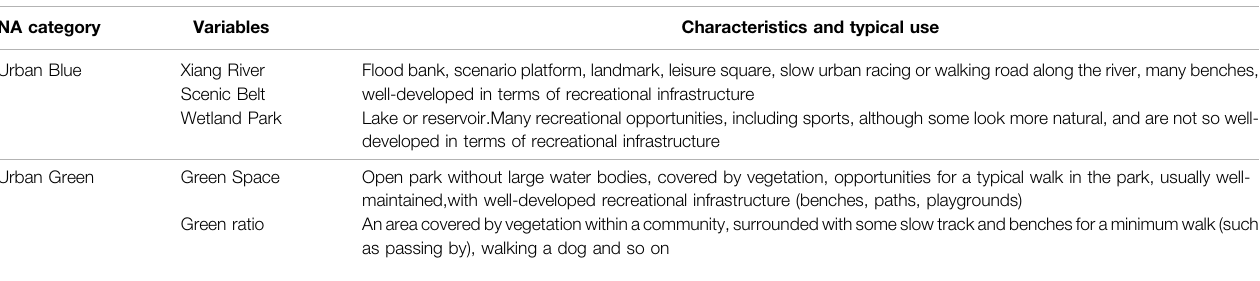
TABLE 2 | NA categories in Changsha identi fi ed in this